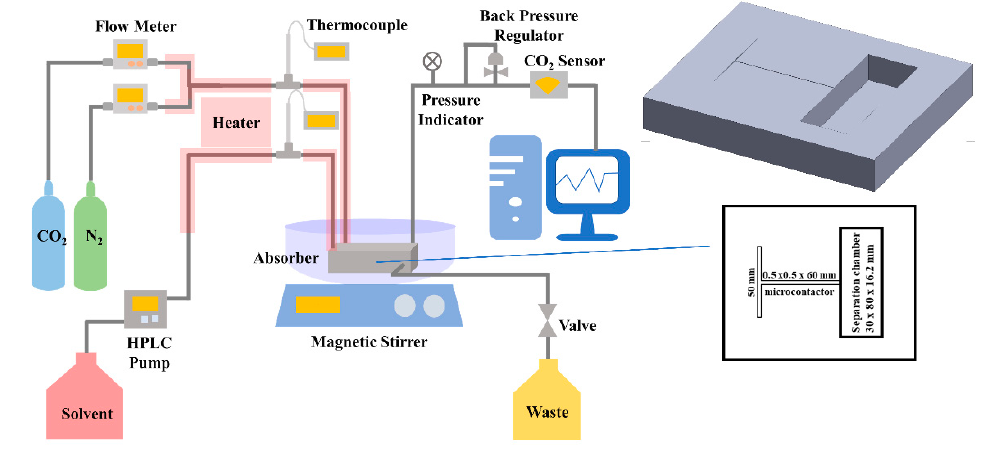
Figure 1. Equipment and experimental set-up for CO 2 absorption process.